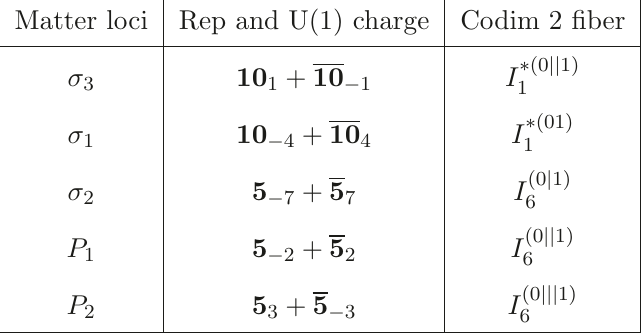
Table 1 . Matter loci and U(1)-charges for the I (0 || 1)